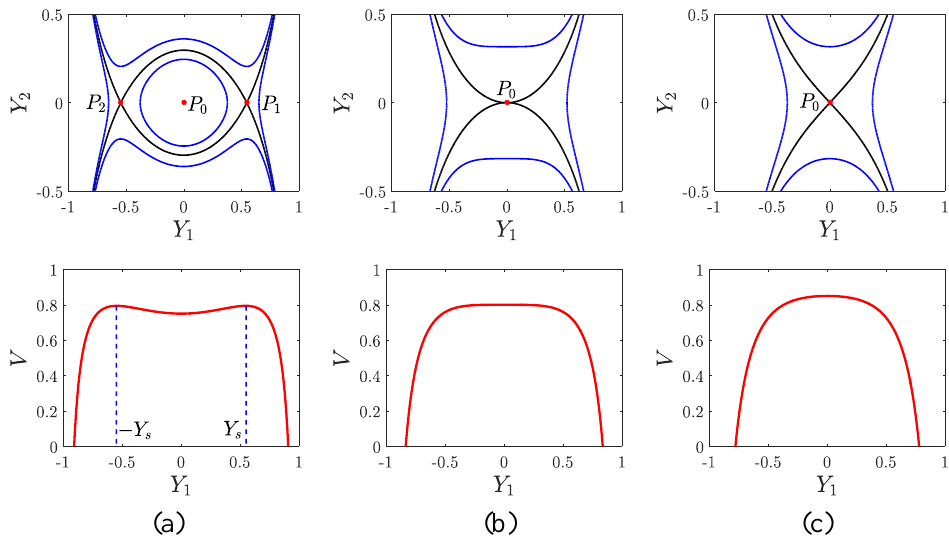
Figure 3. Phase trajectories and potential energy curves of the system; ( a ) e Y = 0.5, ( b ) e Y = 1, and ( c ) e Y =